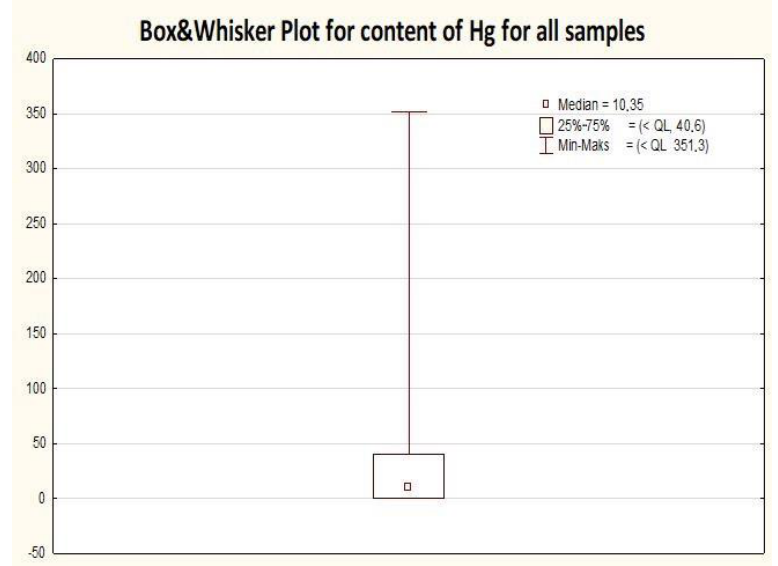
Figure 1. Box and whisker plot for the content of Hg for all studied samples (canned fish, matrices, and seafood products) ( n = 489) (µg/kg).